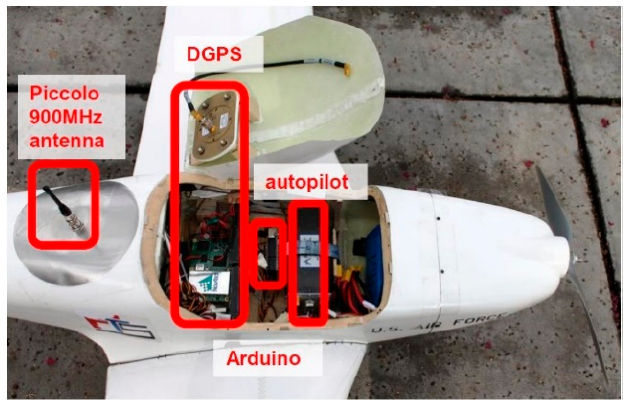
Figure 2. Model instrumentation.